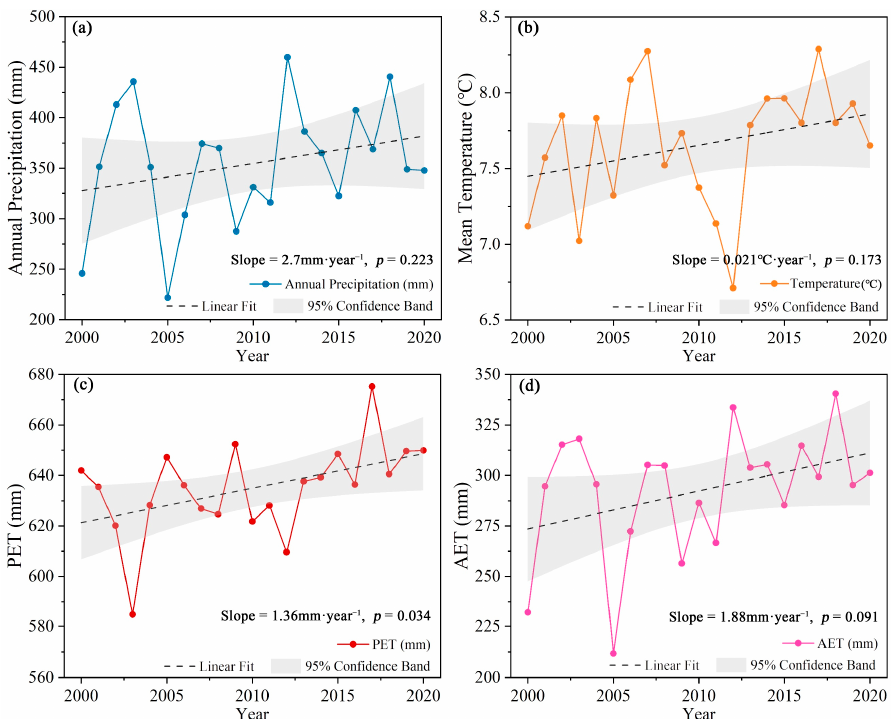
Figure 3. Annual precipitation ( a ), mean temperature ( b ), PET ( c ), AET ( d ) in the HBOY region from 2000 to 2020. Table 4. Transition matrix of land use types between 2000 and 2020 in the HBOY region (Unit: km 2 ). Land Use